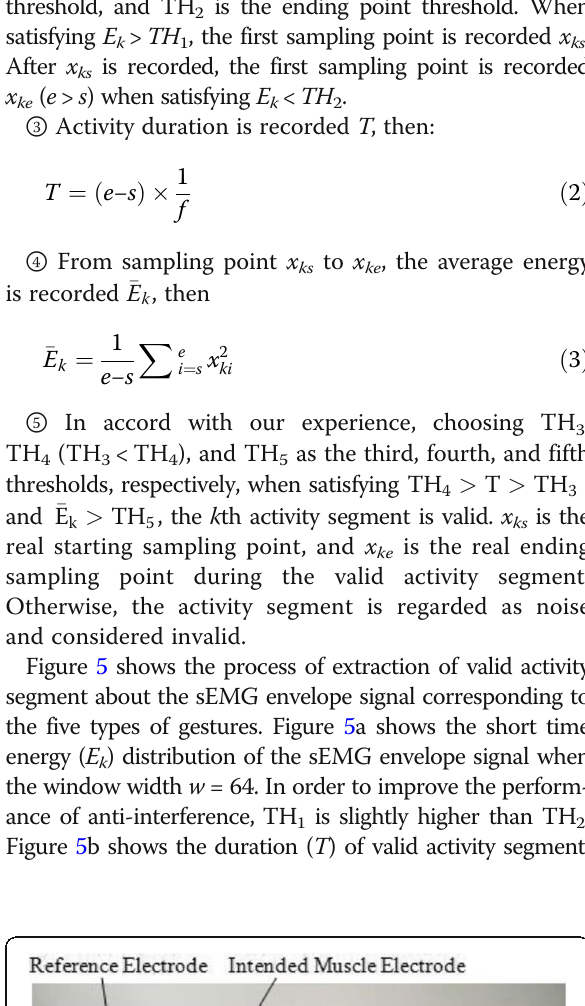
Table 1 Classification distribution of the sample in training